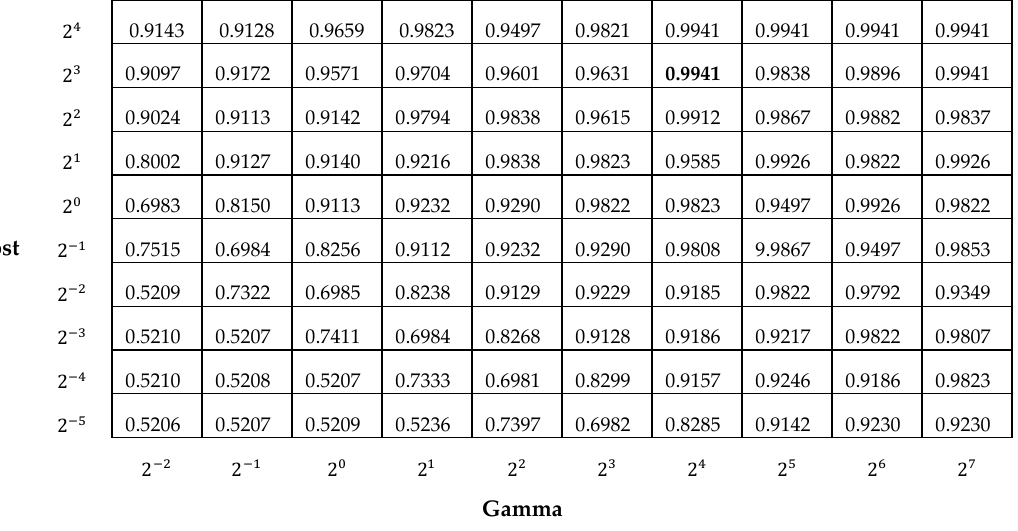
Figure 13. Mean score after CV.